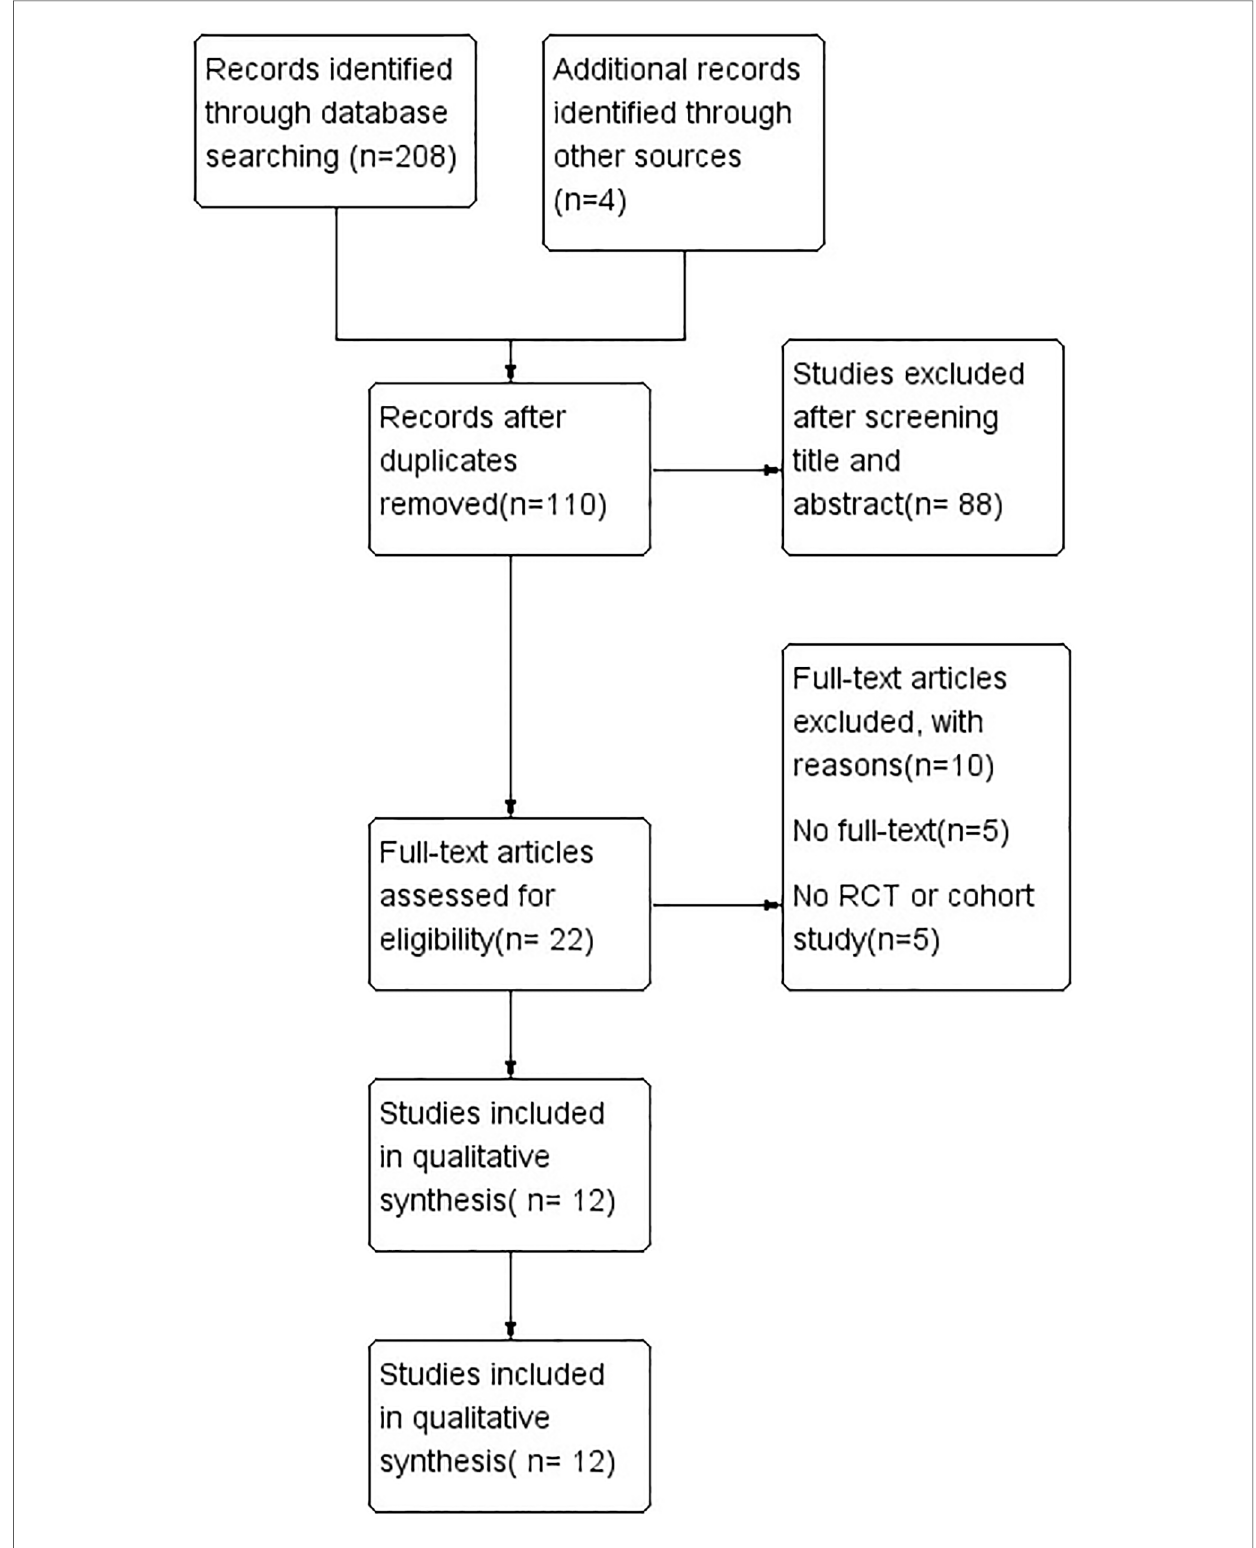
FIGURE 1 Search fl ow diagram. The search fl ow diagram summarizes the search, screening, retrieval, and appraisal of articles fi nally included in the network meta-